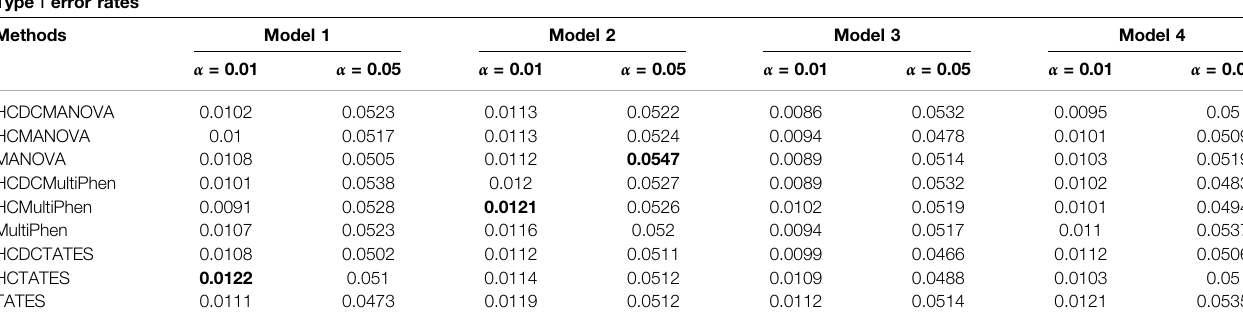
TABLE 1 | Evaluations of type Ⅰ error rates of the nine methods in four simulation models.